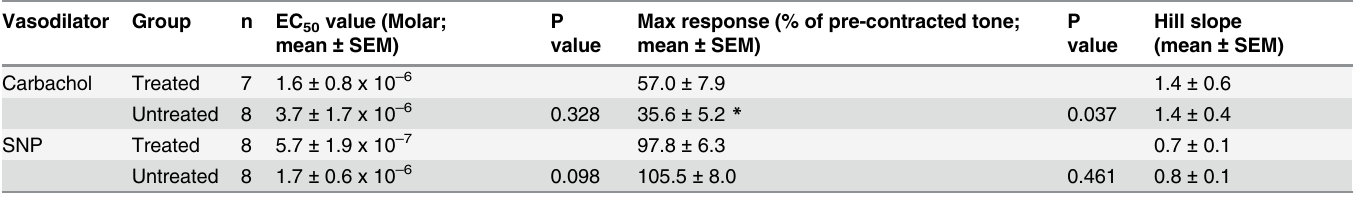
* Indicates signi fi cant difference between groups; unpaired t -test. SNP, sodium nitroprusside.